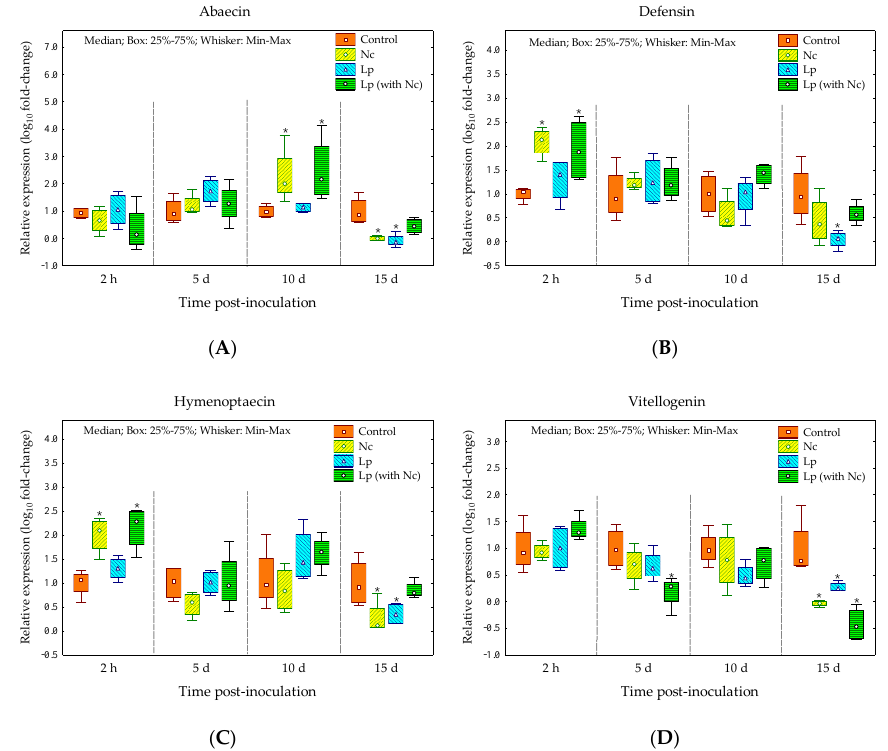
Figure 3. Box plot graphics showing the expressions (relative expressions) of genes encoding the antimicrobial peptides abaecin (A) , defensin (B) , hymenoptaecin (C) and vitellogenin (Vg) (D) in bees naturally infected with L. passim (Lp), healthy bees inoculated with N. ceranae (Nc), bees that were L. passim -infected and inoculated with N. ceranae (Lp (with Nc)) and uninfected honey bees (control). Asterisks in the box plot indicate significant differences (* = p < 0.05) with respect to the control group, according to the post hoc Dunnett test for each time post-inoculation (2 h, as well as 5, 10 and 15 days).